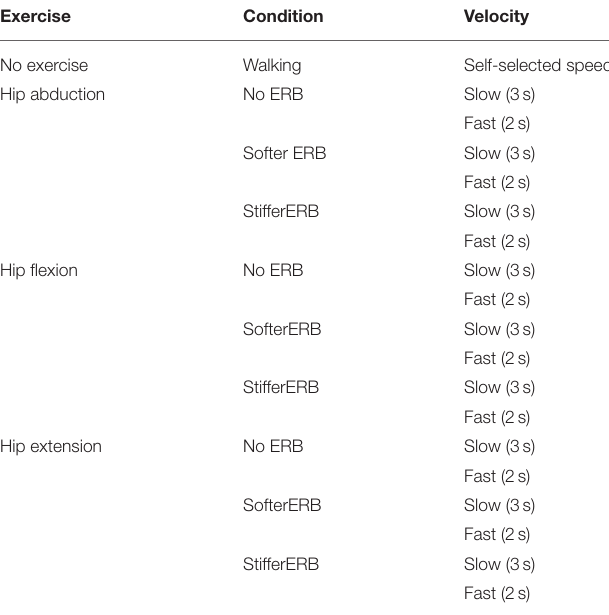
TABLE 1 | Exercise variations and